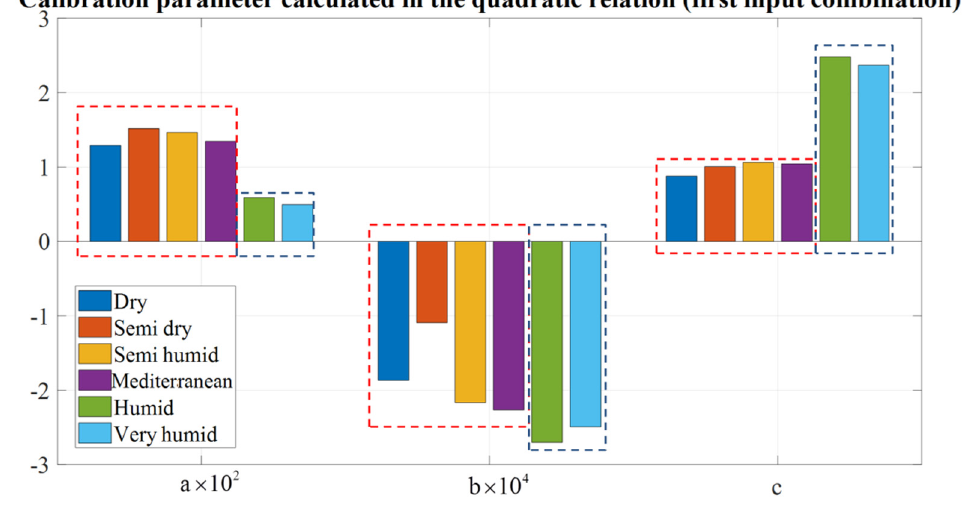
Figure 6. Graphical representation of weights of the six experimental relationships with the two- parameter input combination (a, b, and c, see Table 1) for the six different climate types in Iran.